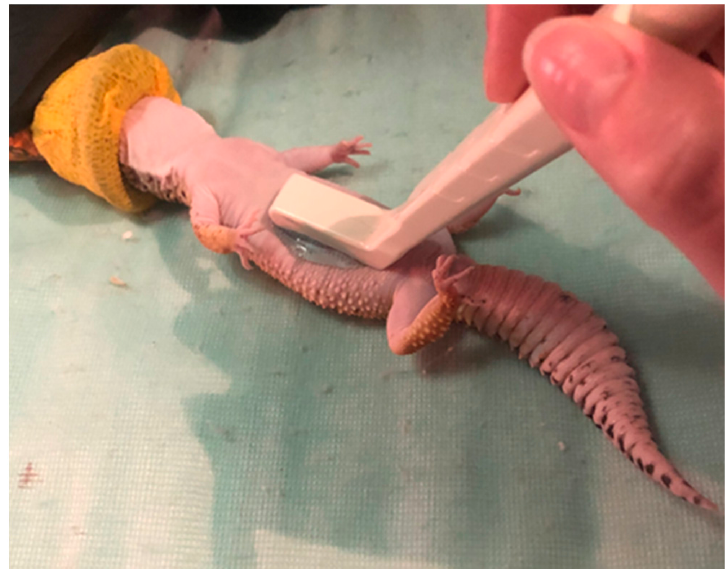
Figure 1. Ultrasounding leopard gecko to measure testicle size.